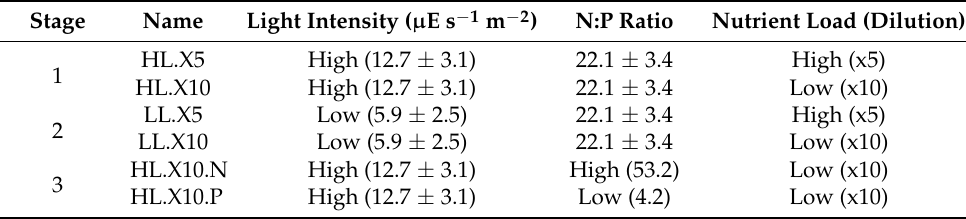
Table 2. Operational characteristics of different